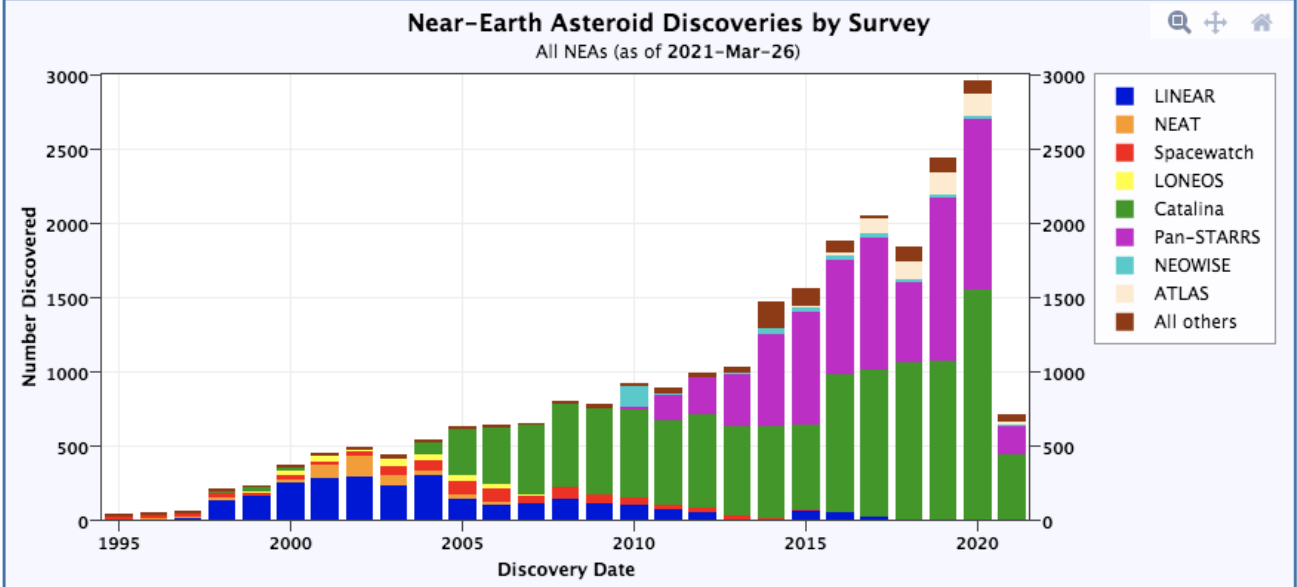
Figure 3. Timeline of NEO discoveries by survey. From https://cneos.jpl.nasa.gov/stats, (accessed on 20 March